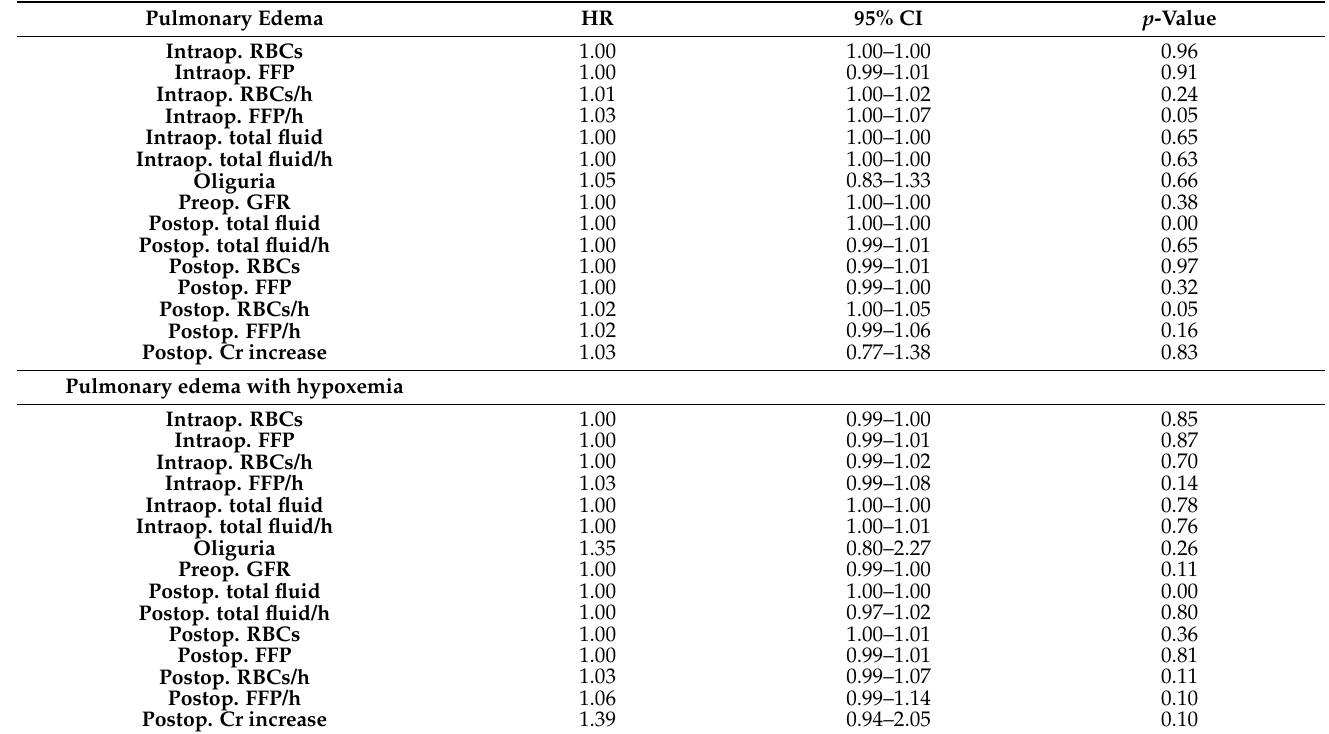
Table 4. Adjusted hazard ratios for postoperative pulmonary edema and pulmonary edema with hypoxemia during emergency surgery. Pulmonary